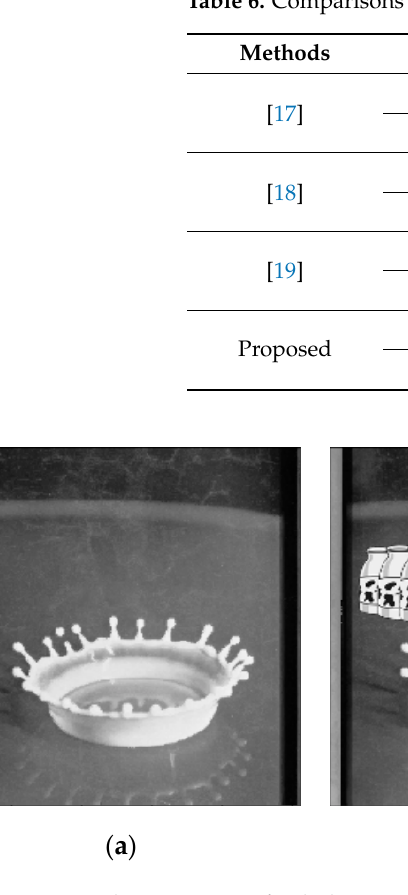
Figure 10. The tampering of Splash image. ( a ) Marked image; ( b ) Tampered image; ( c ) Tampered